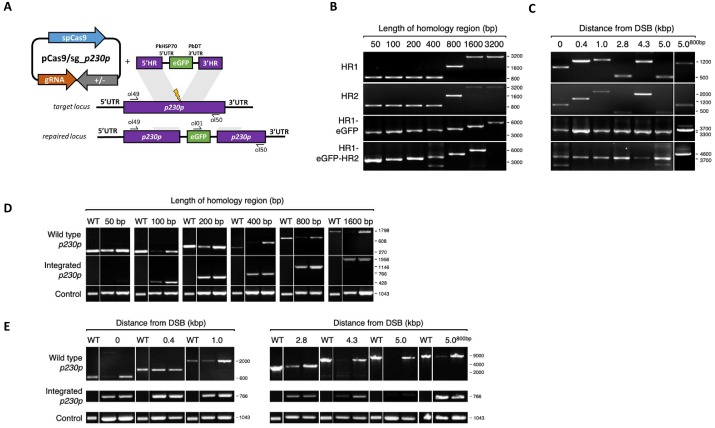
Schematic and genotypic analysis of fusion PCR repair template integration into p230p locus.(A) Schematic of CRISPR-Cas9 strategy. Integration of the eGFP expression cassette into the target p230p locus via homologous recombination using PCR repair template. Arrows indicating oligo positions for diagnostic PCRs. (B–C) Three-step nested PCR products to generate CRISPR-Cas9 repair templates of varying sizes (B) and of distance from the double strand break (DSB) (C). In the first step homology region 1 (HR1) and HR2 are generated individually with eGFP cassette adaptors. Varying band sizes (e.g. for 50 to 400 bp HRs the same 800 bp product was generated) reflect different length of overhangs to allow a subsequent nested PCR step. In the second step HR1 and eGFP cassette are fused followed by the third and final step of fusing HR2 to the previous generated HR1-eGFP product. (D) Parasites transfected with pCas9/sg_p230p and PCR repair templates with HRs ranging from 50 to 1600 bp were analysed with diagnostic PCRs. PCRs of two transfections are shown. PCR reactions detecting the wild type locus, integration locus and a control PCR targeting an unrelated locus (ol75 +ol76) using approximately 3 ng/µl genomic DNA for each reaction. Forward primers for WT and integration PCRs are positioned approximately 100 bp before the start of the 5’HR. Reverse primers for WT are positioned approximately 100 bp after the end of the 3’HR. Reverse primer for eGFP integration is the same for all integration PCRs (ol809). (E) Parasites transfected with pCas9/sg_p230p and PCR repair templates with HRs of 400 bp or 800 bp of varying distances to the DSB were analysed with diagnostic PCRs. PCRs of two transfections are shown. PCR reactions detecting the wild type locus, integration locus and a control PCR targeting an unrelated locus (ol75 +ol76) using approximately 3 ng/µl genomic DNA. Forward primers for WT and integration PCRs are positioned approximately 100 bp before the start of the 5’HR. Reverse primers for WT are positioned approximately 100 bp after the end of the 3’HR. Reverse primer for eGFP integration is the same for all integration PCRs (ol809). All primer sequences are listed in Figure 5—source data 2.